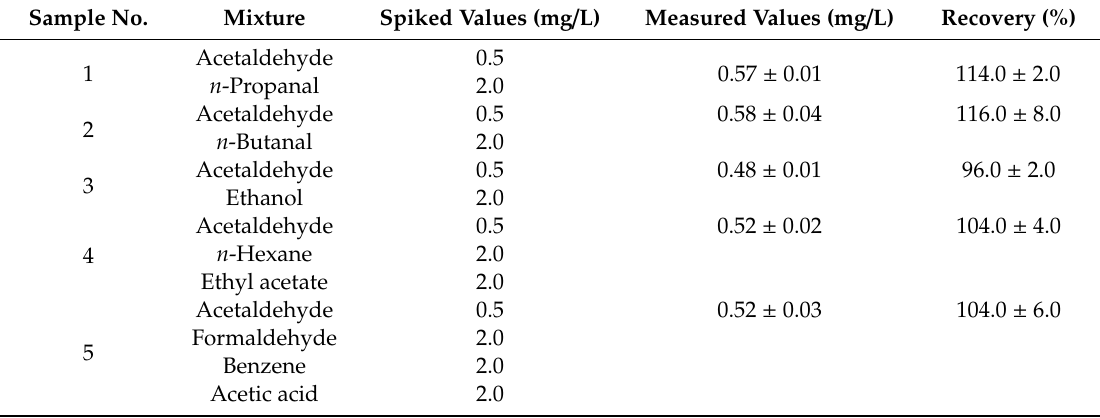
Table 2. Detection of acetaldehyde in five artificial samples by the present sensor ( n = 5). Sample No.